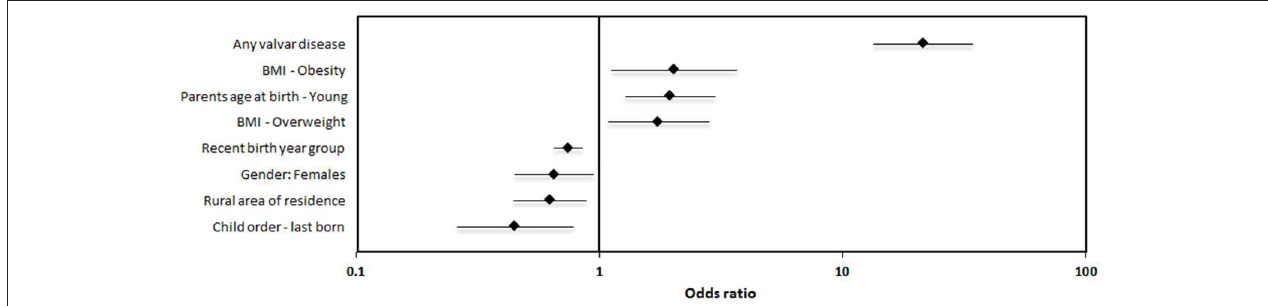
FIGURE 3 | Forest plots of multivariate regression analysis. The correlates [Rhombus – Odds ratio (OR) and bars – 95% confidence intervals (CI)] of variables significantly associated with